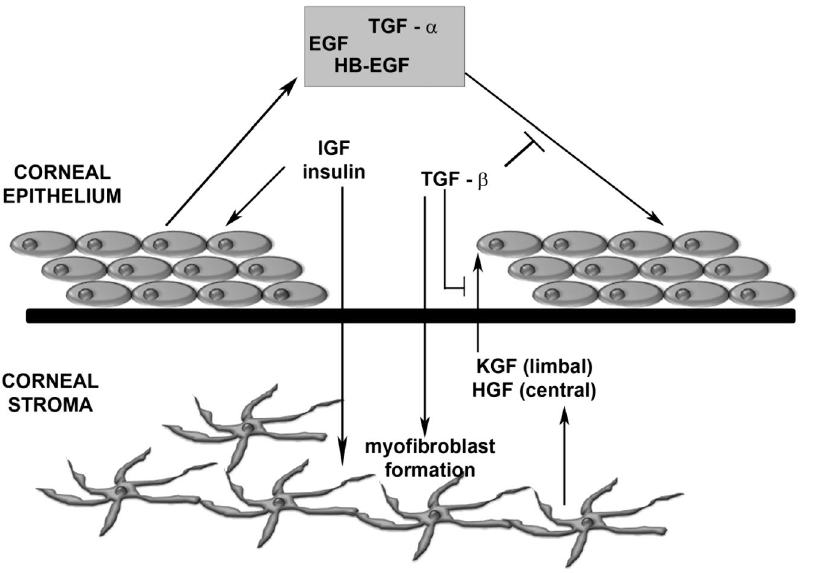
Figure 1. Corneal wound healing. A number of growth factors and cytokines are released following epithelial injury in the cornea. These factors mediate the epithelial-stromal interactions that are critical for wound healing. Keratinocyte growth factor (KGF) and hepatocytes growth factor (HGF) are produced by stromal keratocytes, and interleukin-1 (IL-1) and platelet-derive growth factor (PDGF) are secreted by epithelial cells to regulate stromal responses to injury. Epidermal growth factor (EGF), IGF and transforming growth factor b (TGF- b ) play roles in both epithelium and stromal repair. Cross-talk between these factors ultimately determines the outcome of corneal wound healing.